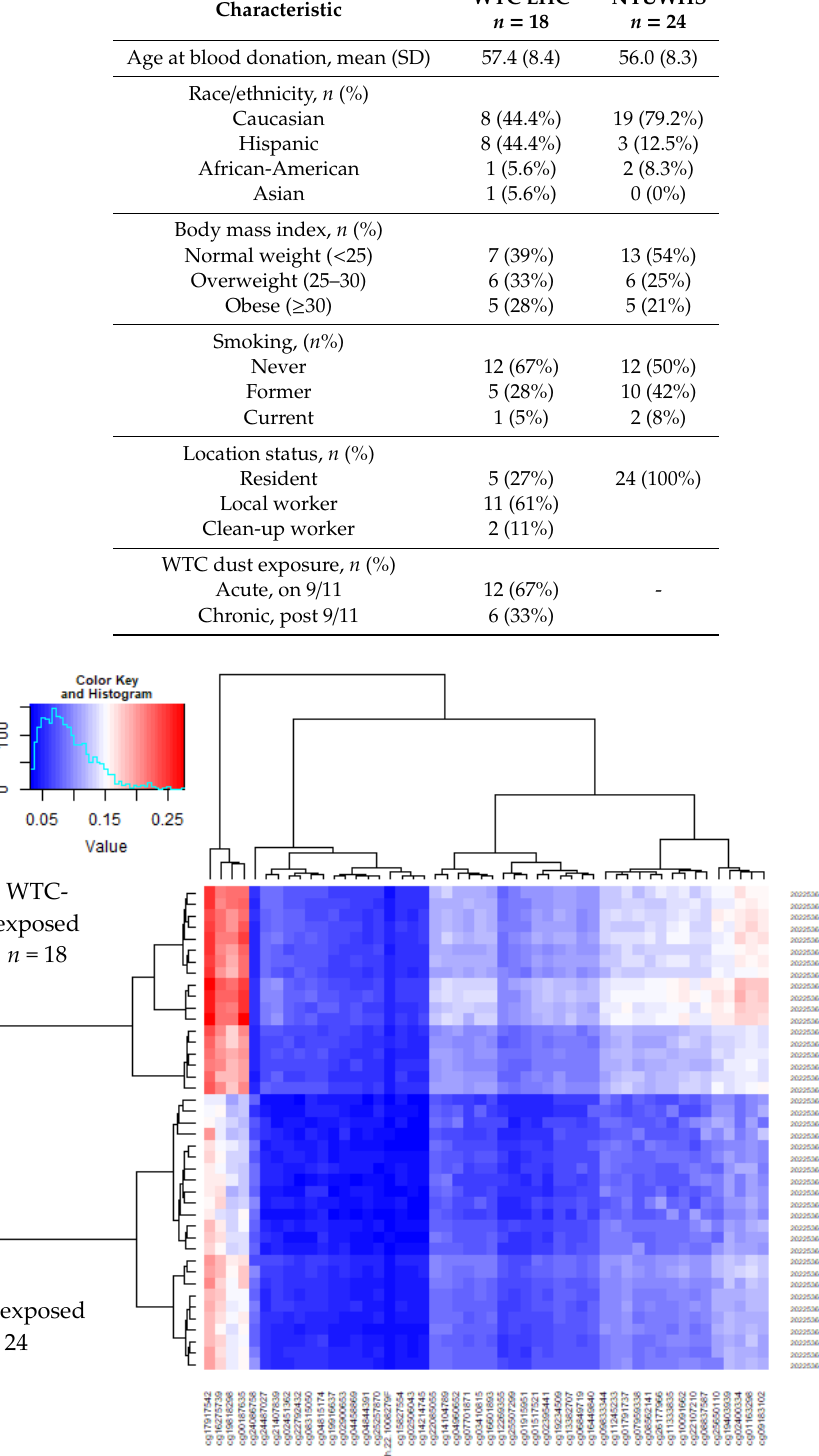
Figure 1. Unsupervised hierarchial clustering heatmap for the 50 most significantly di ff erentially methylated CpG sites between the WTC-exposed (WTC EHC) vs. unexposed (NYUWHS) cancer-free